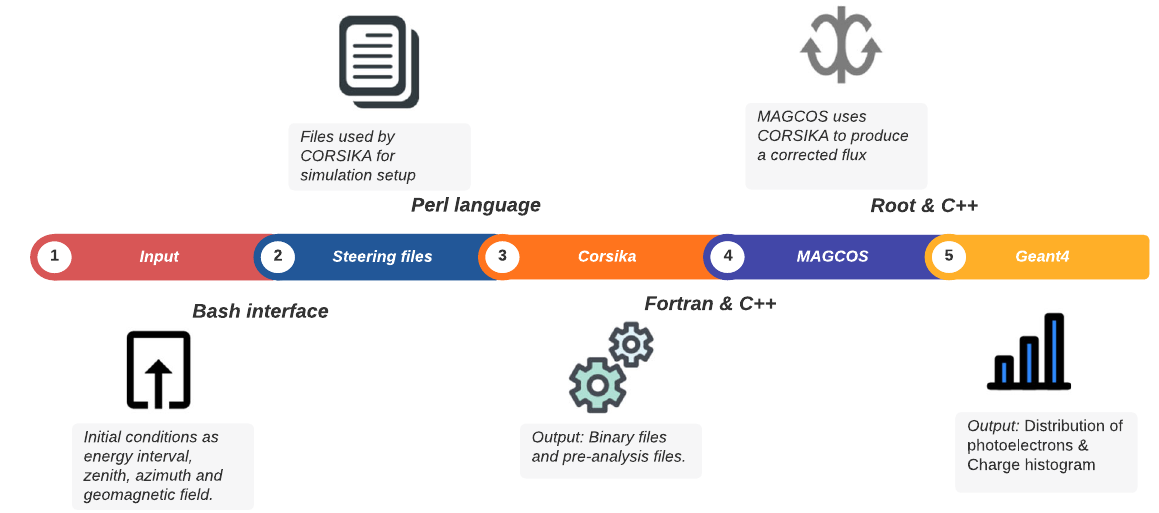
Fig. 2 As the simulation evolves, the different ARTI modules call CORSIKA, MAGCOS, or Geant4 to accurately calculate the signal flux at the detector expected by the integrated cosmic ray flux. The simulation moves forward as a sequence: the results from one steps are used as inputs for the next